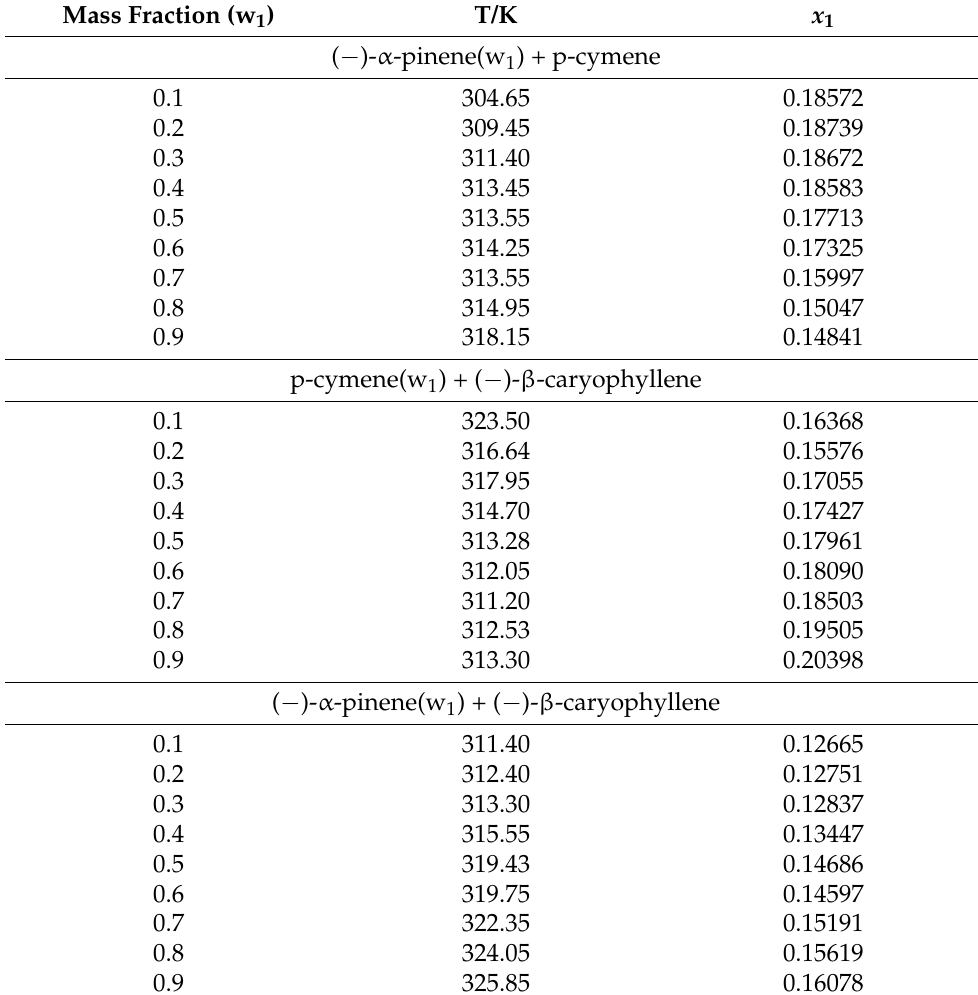
Table 13. Values of experimental mole-fraction solubility (x 1 ) of dehydroabietic acid in the binary solvent at temperature T and pressure P = 101.3 kPa a